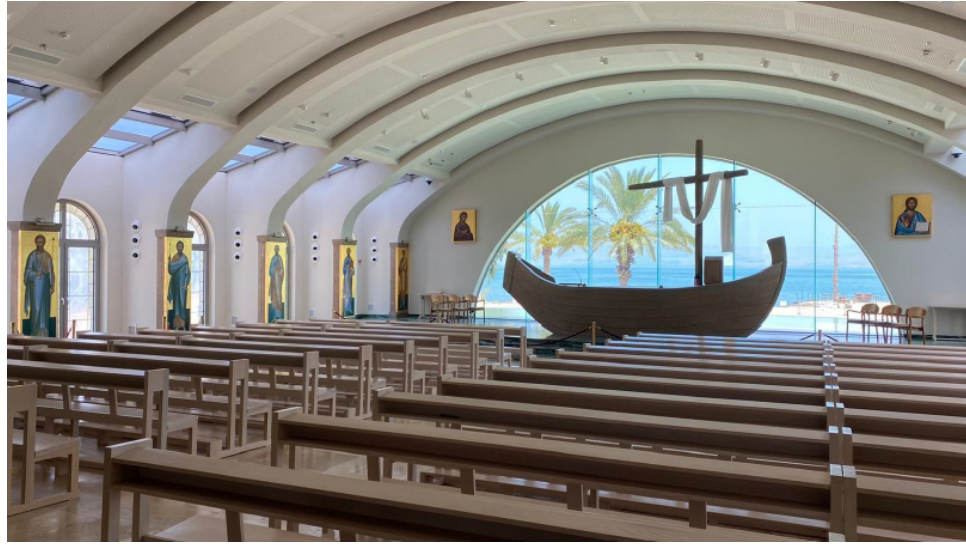
Figure 13. The Boat Chapel (photo: Assaf Pinkus).